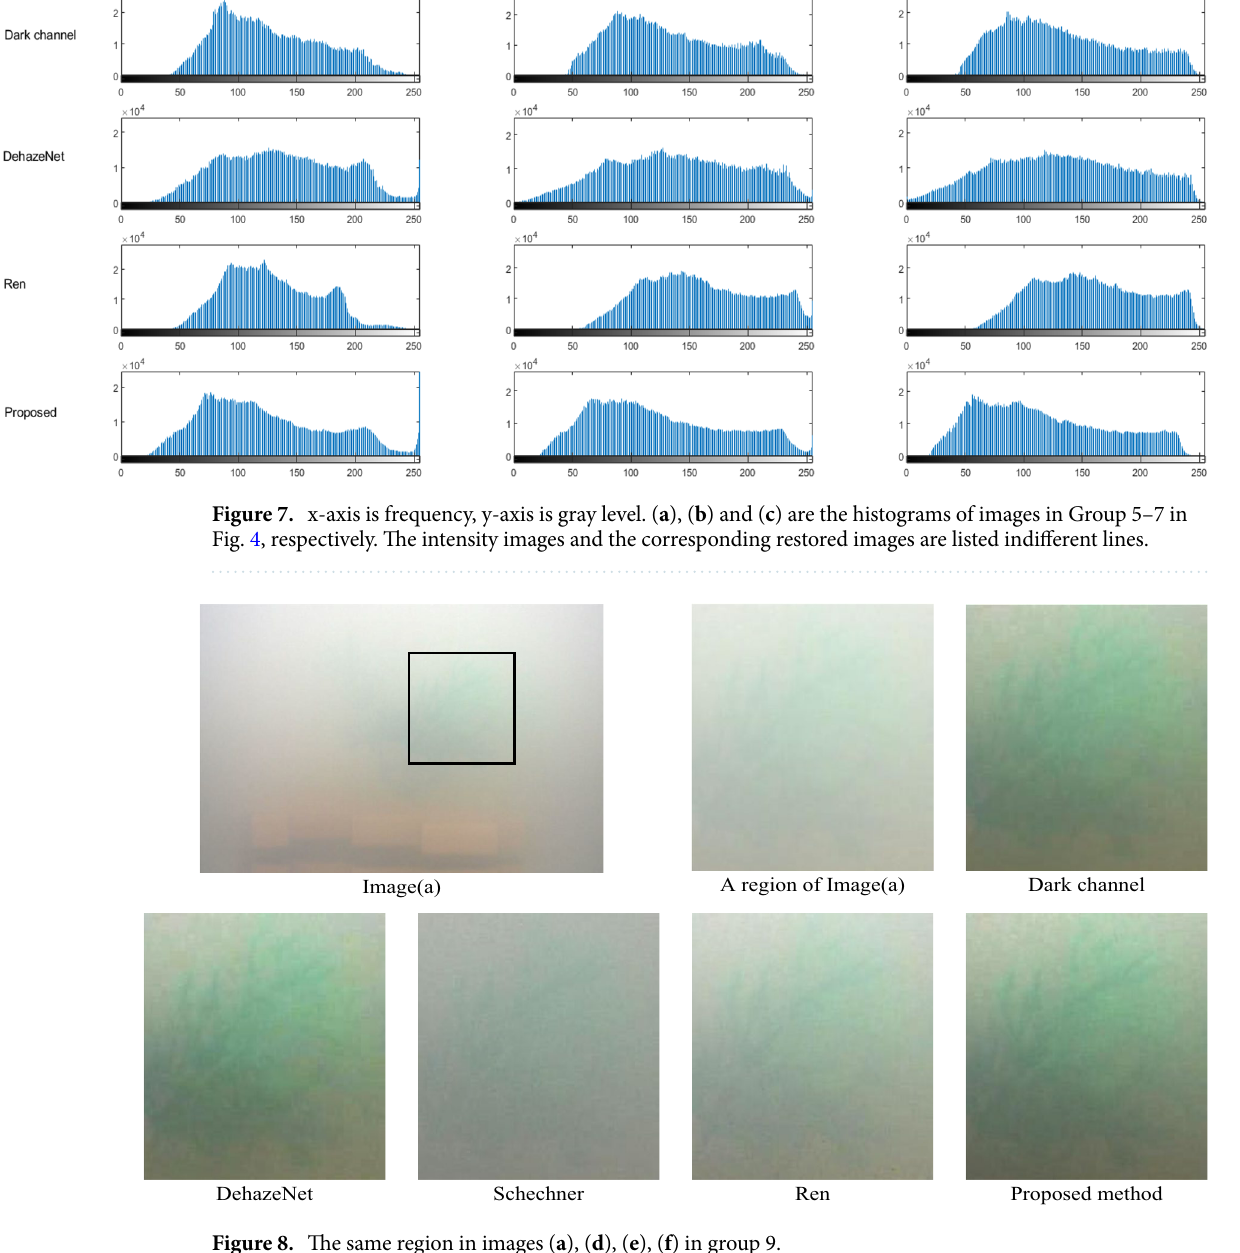
gray value change rate of the image. The larger average gradient of image is, the better details of the image are. Information entropy reflects the amount of information contained in an image. An image with larger informa- tion entropy contains more information. In Table 1, the bold data indicates the maximum value of every group, and the percentage in brackets indi- cates the improvement of the proposed method compared with the intensity image. As can be seen from Table 1, compared with the intensity image, contrast, gray standard deviation, average gradient and information entropy of the restored images are improved evidently. In general, compared with intensity images, the standard deviation